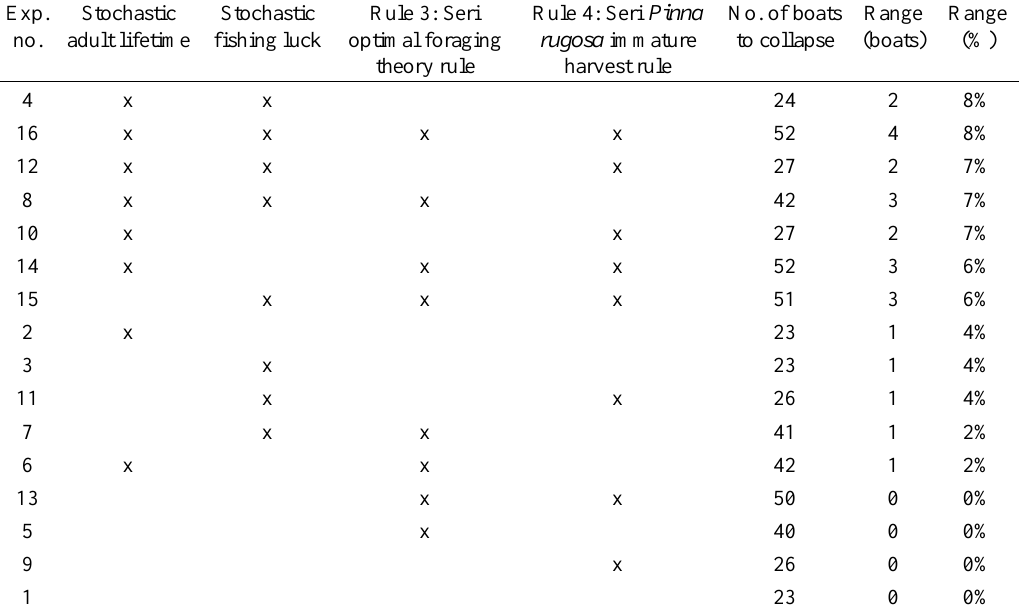
Table 3. Collapse experiments, sorted by the range of collapse thresholds in different runs (as percent of collapse threshold). The letter x indicates which stochastic variables and/or institutional rules are active in each experiment. Range represents the difference between the number of boats needed to trigger collapse in one stochastic run and the number of boats needed to trigger collapse in every stochastic run. Exp.